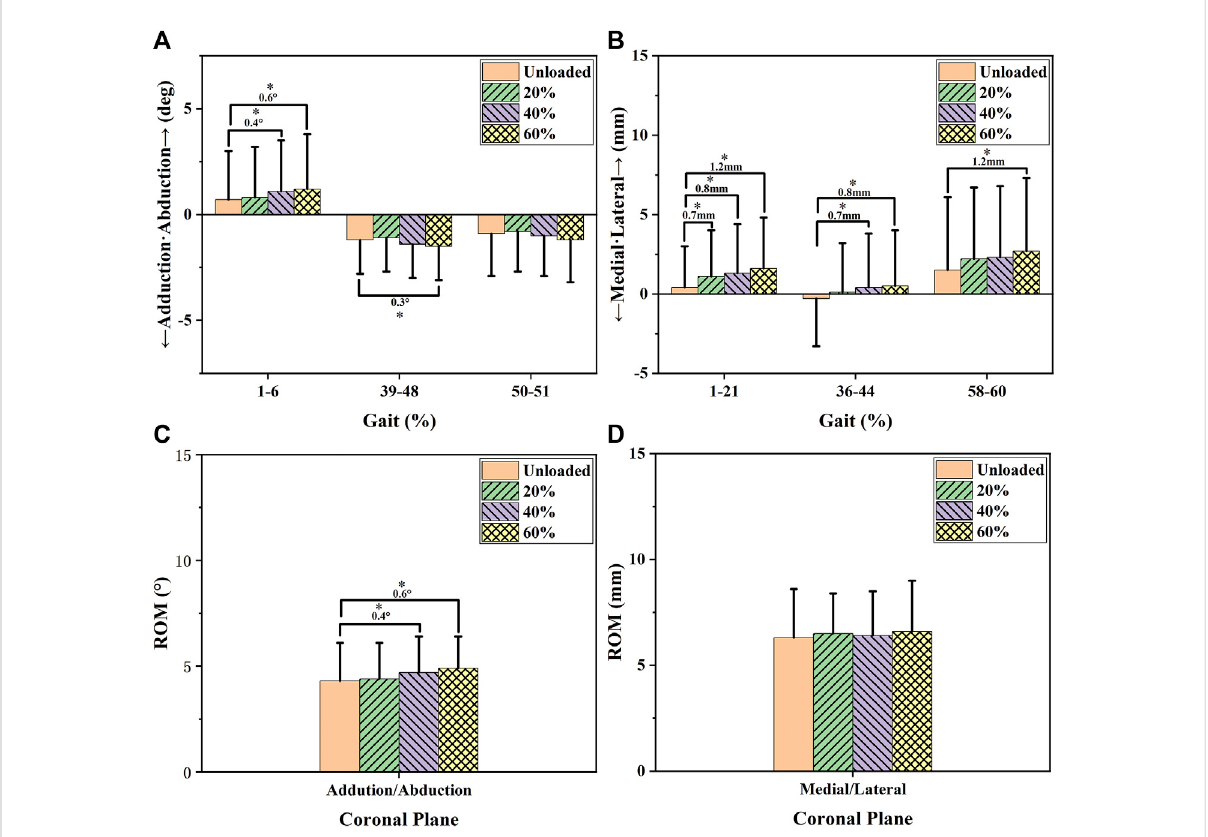
FIGURE 4 Coronal ROM and average knee kinematic alterations during the phases affected by increased load levels. Charts (A and B) show the average knee kinematics of the affected phases (i.e., the phases marked by colored bars in Figure 2) under increased load levels. Charts (C and D) show the ROM of coronal knee kinematics in increased load levels. The differences in knee kinematics between the unloaded level and load levels of 20, 40, and 60%BW were compared using a statistical signi fi cance level of 0.05. The number and * in the chart represent the differences in magnitude and signi fi cant differences between the groups ( p <